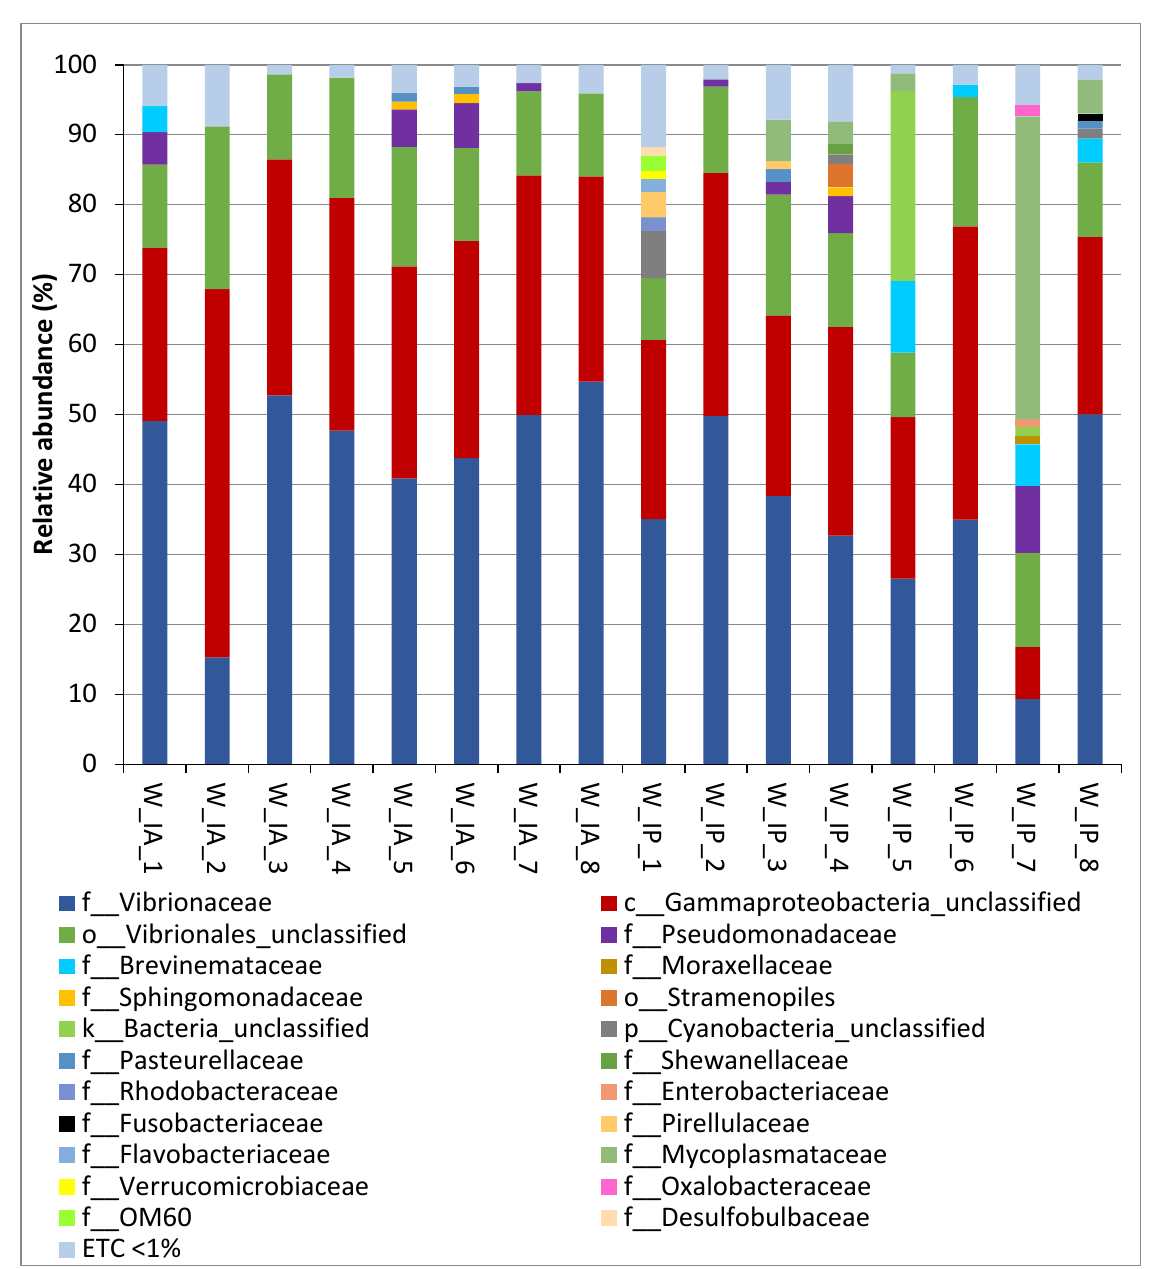
Figure 4. Relative abundance (percentage) at family level for each sample of intestinal microbiota from anterior and posterior sections of wild C. labrosus . In the figure, W_IA corresponds to the anterior intestinal section of wild fish, and W_IP corresponds to the posterior intestinal section of wild fish. ETC: families < 1%.